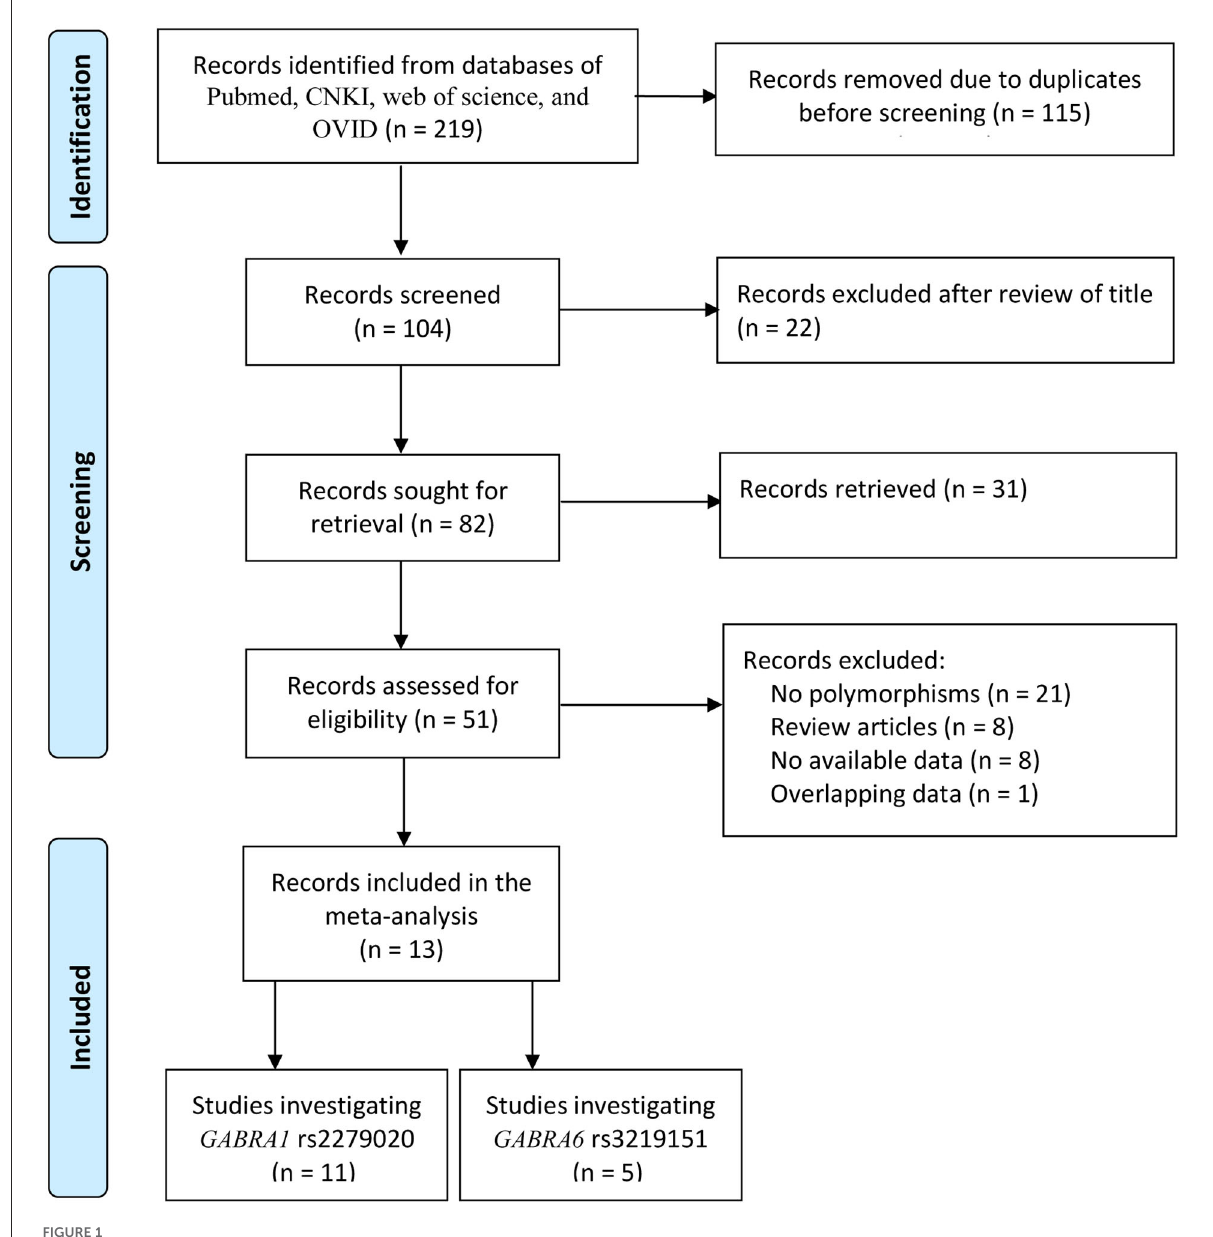
FIGURE1 Flow diagram of selection